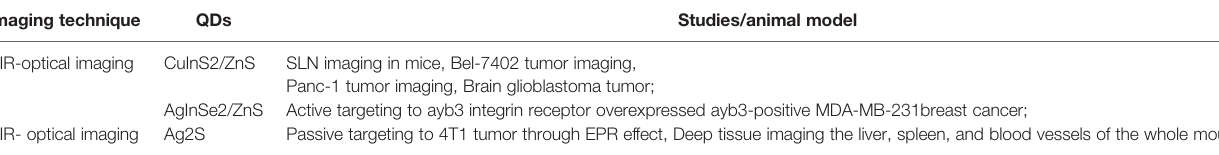
TABLE 2 | Preclinical use of NIR biocompatible QDs in cancer imaging. Imaging technique